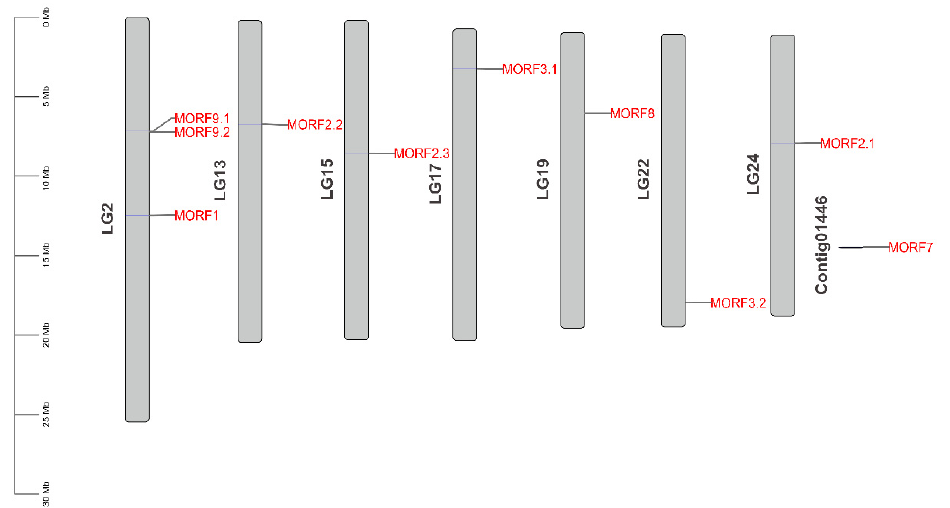
Figure 4. Chromosomal locations of MORF genes in kiwifruit. The chromosomal locations of the MORF genes were mapped with TBtools [28].